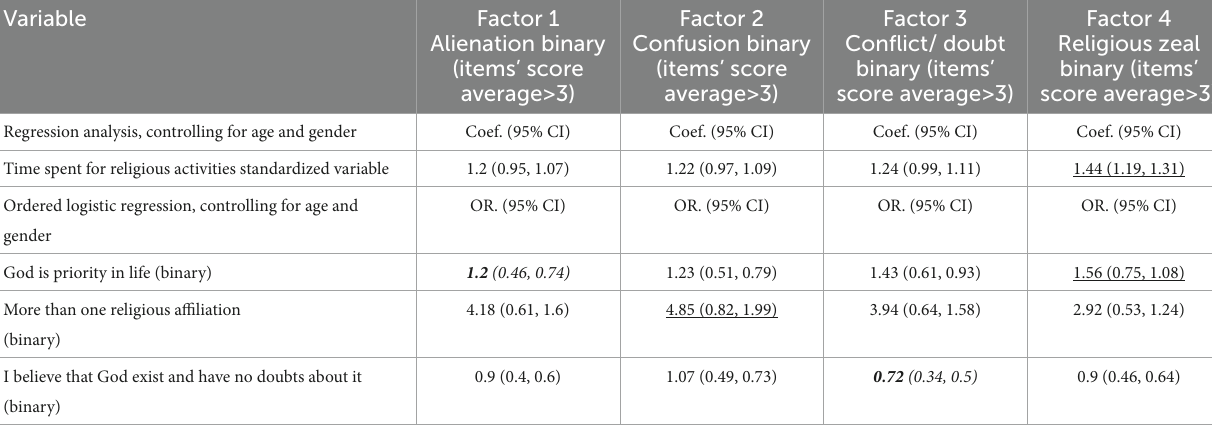
TABLE 4 External validation of factors: Associations of new RSS sub-domains with alternative measures of religious practice.